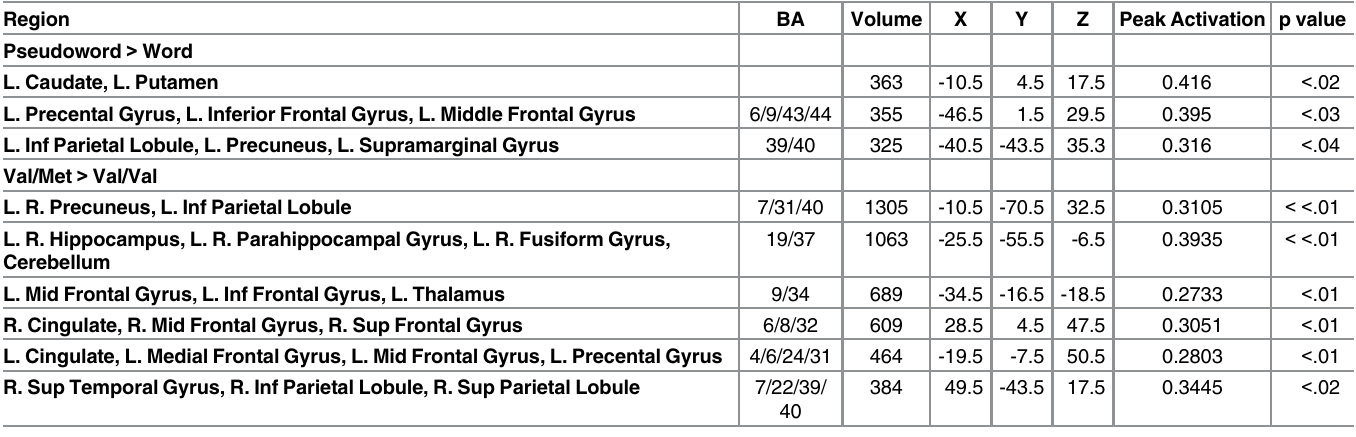
Table 3. Neural activation differences by condition and group.